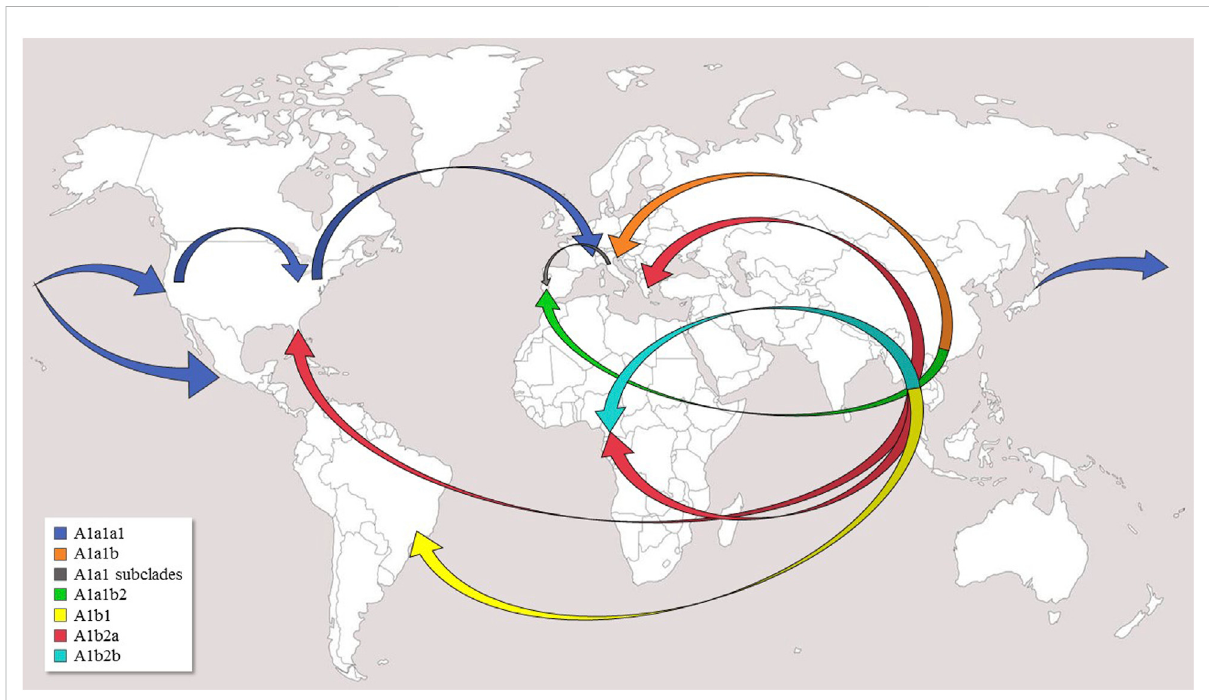
FIGURE 2 Possibleworldwidediffusionroutesof Ae.albopictus .Arrowsindicatepostulateddiffusionroutesfromthenativehome-range(South-EastAsia) and subsequent dispersals of major clades and subclades within haplogroup A1. The original world map is from the website (http://www.